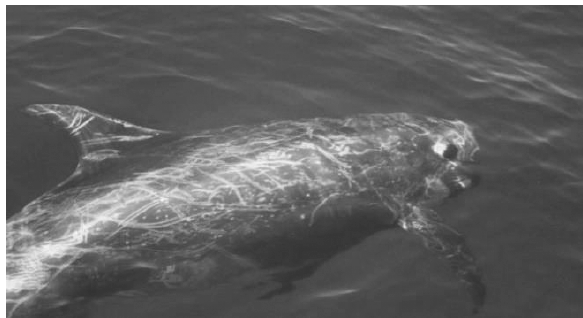
Figure 5. Risso’s dolphin during survey offshore the Gulf of Cata- nia. (Photo by Ketos association).